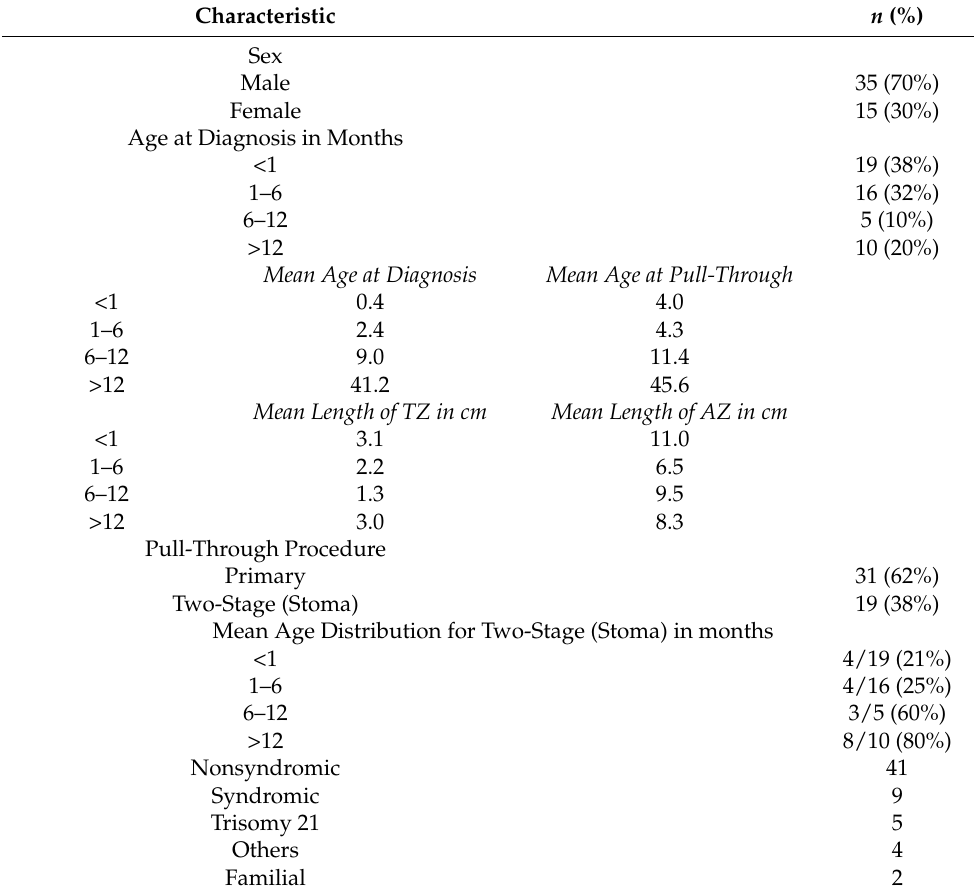
Table 1. Demographics of the patients included in the